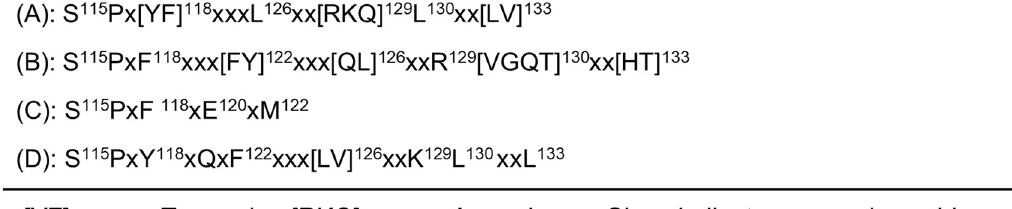
a pre-GSK3 β -binding site (115SPxF118) (20 species compared with one bacterium). The asso- ciation of DUF727 with the pre-GSK3 β -binding site in vertebrate ARMC4 suggests that DUF727 (SSF103107) originates in a primitive stage of evolution. We suggest that the gene